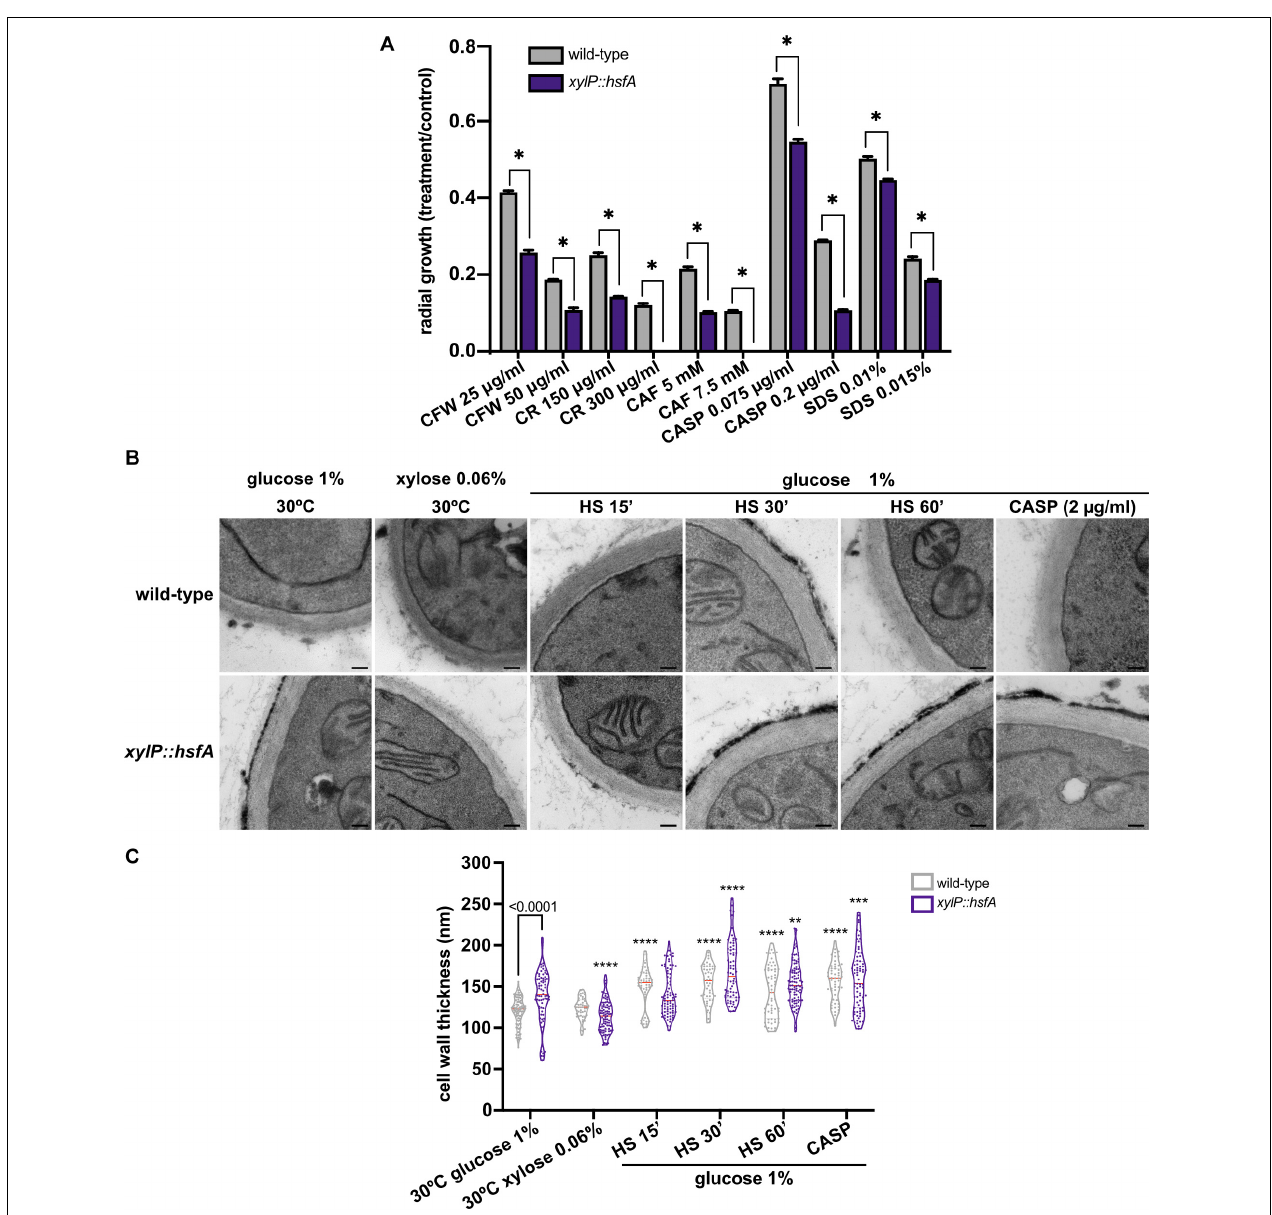
FIGURE 4 | The xylP::hsfA mutant is more susceptible to cell wall stress. (A) A total of 1 × 10 4 conidia of the wild-type and xylP::hsfA strains were inoculated onto solid MM supplemented with 0.06% xylose (low hsfA expression conditions) and varying concentrations of calcofluor white (CFW), congo red (CR), caffeine (CAF), caspofungin (CASP), and sodium dodecil sulfate (SDS). The plates were incubated at 37 ◦ C for 72 h and the ratio of radial growth of treated to the control condition was calculated. The results were expressed as mean ± SD, n = 3. * p ≤ 0.0001 (two-way ANOVA and Sidak’s posttest). (B) HsfA depletion increases cell wall thickness in A. fumigatus . The wild-type and xylP::hsfA strains were grown in liquid MM supplemented with 1% xylose for 36 h at 30 ◦ C and further incubated in MM (repression) or MM lacking glucose supplemented with xylose 0.06% (induction) for 4 h at 30 ◦ C. Next, the repressed samples were heat-shocked at 48 ◦ C for 15, 30, and 60 min or treated with 2 µ g/ml of CASP for 60 min, and prepared for transmission electron microscopy analysis. Black bars: 100 nm. (C) Cell wall thickness measurement of the germlings shown in violin plot of 50 sections of different germlings. Dashed lines indicate the quartiles and red lines indicate the median for each condition. Significant differences were observed by using two-way ANOVA followed by Sidak’s posttest. ** p < 0.01, *** p < 0.001, and **** p < 0.0001 indicate significant differences from comparisons to the same strain at the control (30 ◦ C, glucose 1%) condition. Differences between the strains in the same growth condition are indicated by the